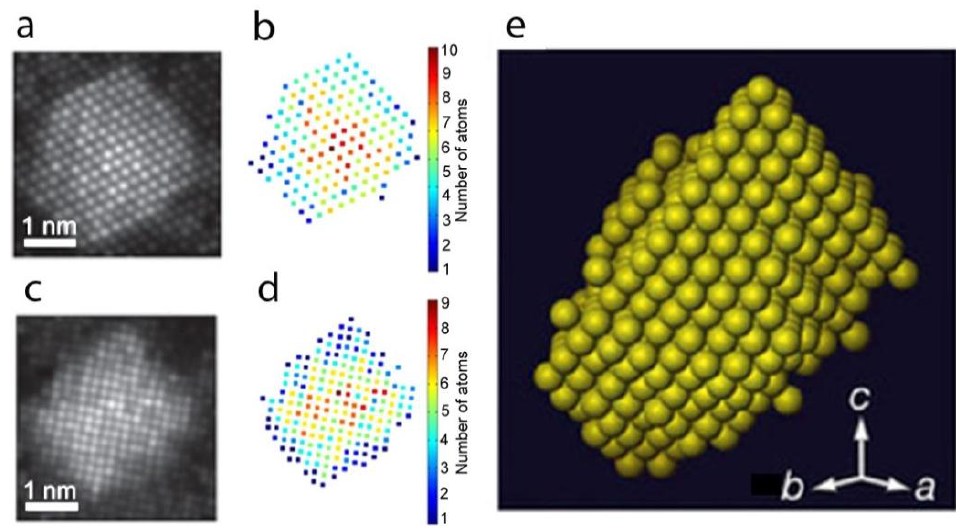
Figure 4. ( a , c ) Refined models for two HAADF-STEM projection images of a Ag atomic cluster embedded in an Al matrix; ( b , d ) Number of Ag atoms per projected atomic column for both images; ( e ) 3D representation of the reconstructed volume of the Ag nanoparticle, based on discrete tomography [59].